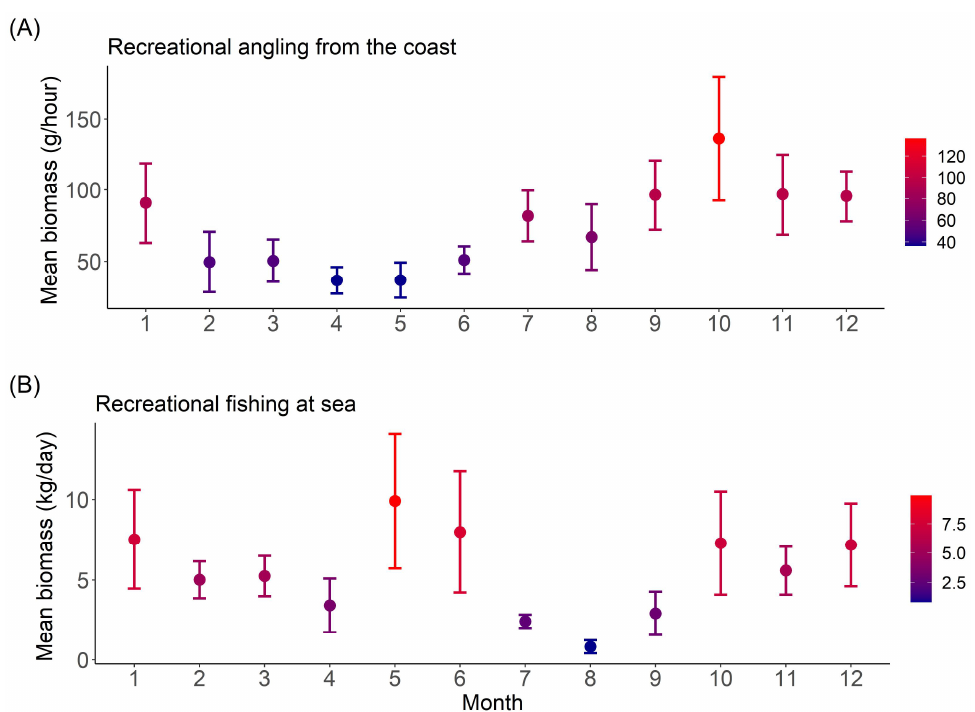
Figure 2. Predicted mean catch biomass (g/hour) for recreational angling from shore ( A ), and recreational angling fishing at sea kg/day ( B ) at each month. When angling from the coast, biomass peaks in the fall (October) and reaches minimum values in spring (April). However, for recreational fishing at sea, biomass peaks in spring and the beginning of summer (May and June), and reaches minimum values in the summer (July–August). Error bars represent standard error.